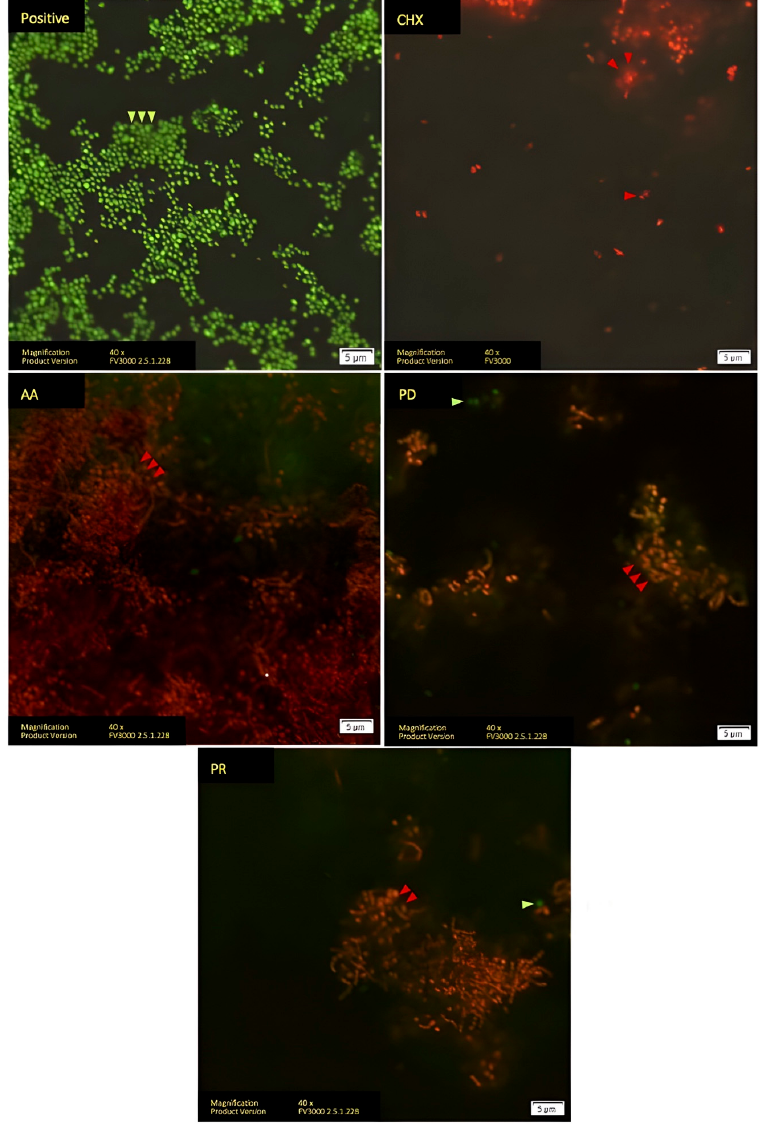
Figure 2. LIVE/DEAD staining analyzed with confocal microscope of Essix ® retainer. Living cells stained with SYTO9 are indicated with green arrows. Dead cells stained with PI are indicated with red arrows.